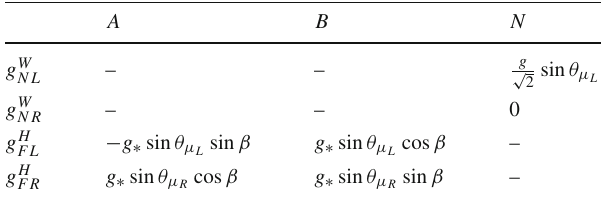
Table 1 Couplings of the composite lepton partners to the elementary left- and right-hand muon with index F = A , B in the leading order of sin θ μ and/or sin θ μ . See texts for details about the absences of both L R γ - and Z -relevant